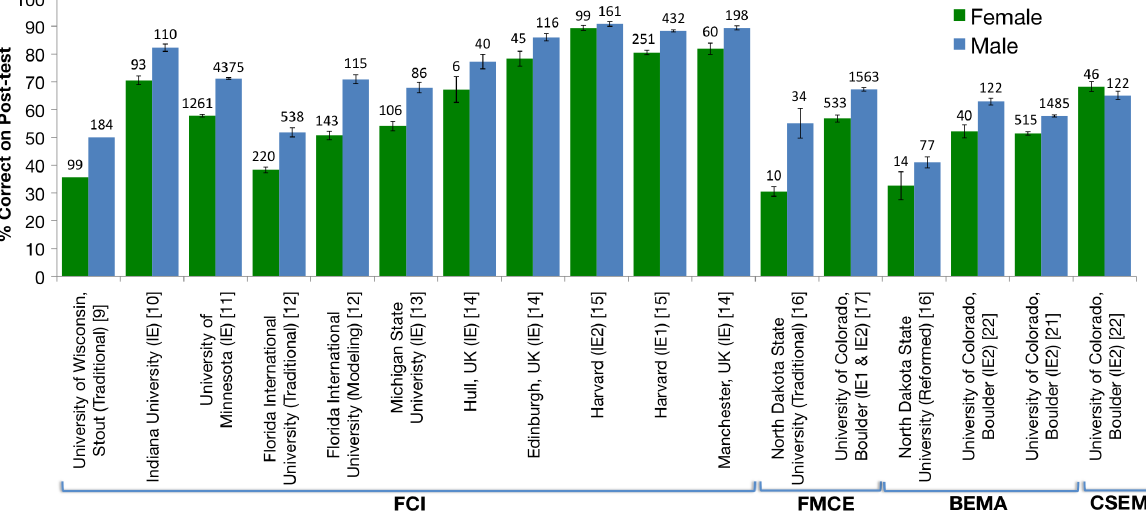
FIG. 2 (color online). Posttest scores for men and women across several institutions on the FCI, FMCE, BEMA, and CSEM. Posttest gender gap is more variable than pretest gender gap. Numbers above bars indicate number of men and women included in the study at each institution. Error bars represent the standard error. If no error bars are present, they were not reported in the study. Instructional methods used in each course are given in parentheses. This graph does not include CSEM data from Ref. [28], which reported only gender gaps and not